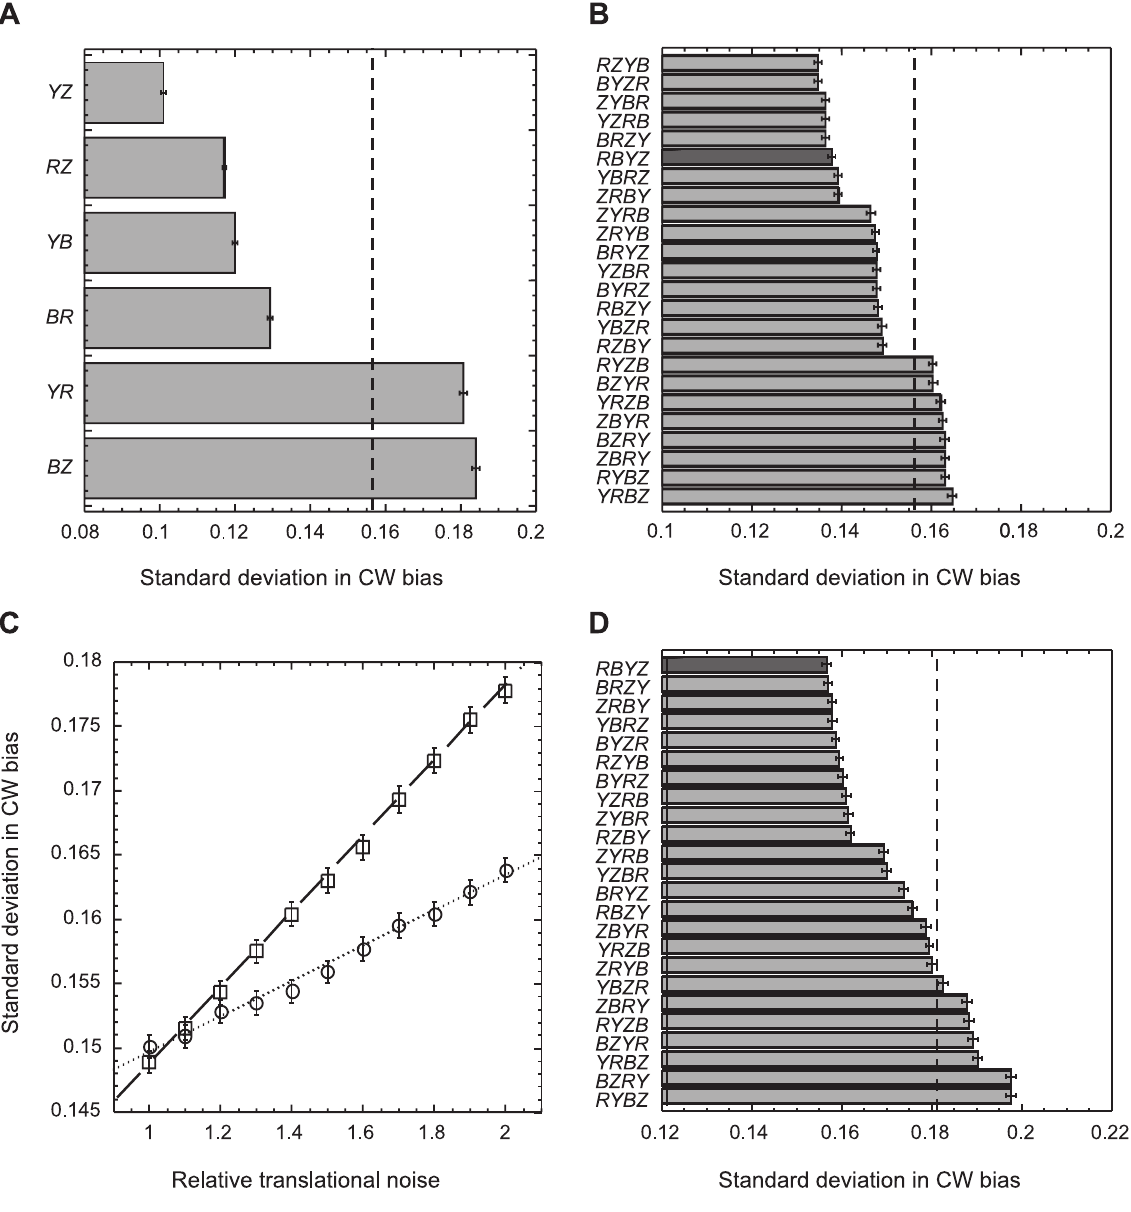
Figure 4. Simulated effects of translational coupling on robustness of the signaling output. Standard deviation of the CW motor bias in a population of 10 5 cells was simulated in presence of gene expression noise as described in Materials and Methods and in supporting information (Text S1). (A) Simulations for 100% pairwise coupling of indicated chemotaxis genes, with remaining genes being uncoupled. (B) Simulations for different arrangements of translationally coupled chemotaxis genes, performed at equal noise levels for all genes and 25% coupling. (C) Asymmetric effects of translational noise for 25% coupling between cheR _ cheZ (circles, dotted line) and cheZ _ cheR (squares, dashed line). Linear fits to the data are guide to the eye. (D) Simulations for different gene orders as in (B), at 1.5-fold higher noise for the weakly expressed cheR and cheB genes. Dark- grey bars indicate gene order in E. coli . Standard deviation of CW bias in absence of coupling is indicated by vertical dashed lines. Genes are indicated by single letters, i.e., Y=CheY, and so forth. Error bars indicate confidence intervals. preferential pairing of particular chemotaxis genes and the the optimal adapted CW bias within a population (Figure 4). resulting gene order on the chromosome can improve robustness Simulating a 100% pairwise translational coupling between of the pathway output—adapted clockwise (CW) rotation bias of particular genes in the background of uncorrelated fluctuations flagellar motor—against translational noise when translational of all other genes (Figure 4A) showed favorable reduction in the coupling is taken into account. Considering four genes cheR , cheB , standard deviation of CW bias for four adjacent gene pairs— cheY , and cheZ , our in silico chemotaxis network model indeed cheY_cheZ , cheR_cheZ , cheY_cheB , and cheR_cheB . Note that because confirmed that positive correlations between expression of of the perfect coupling, the gene order in these simulations is not adjacent genes via translational coupling affect deviations from important, so that cheY_cheZ and cheZ_cheY pairs are equivalent. In